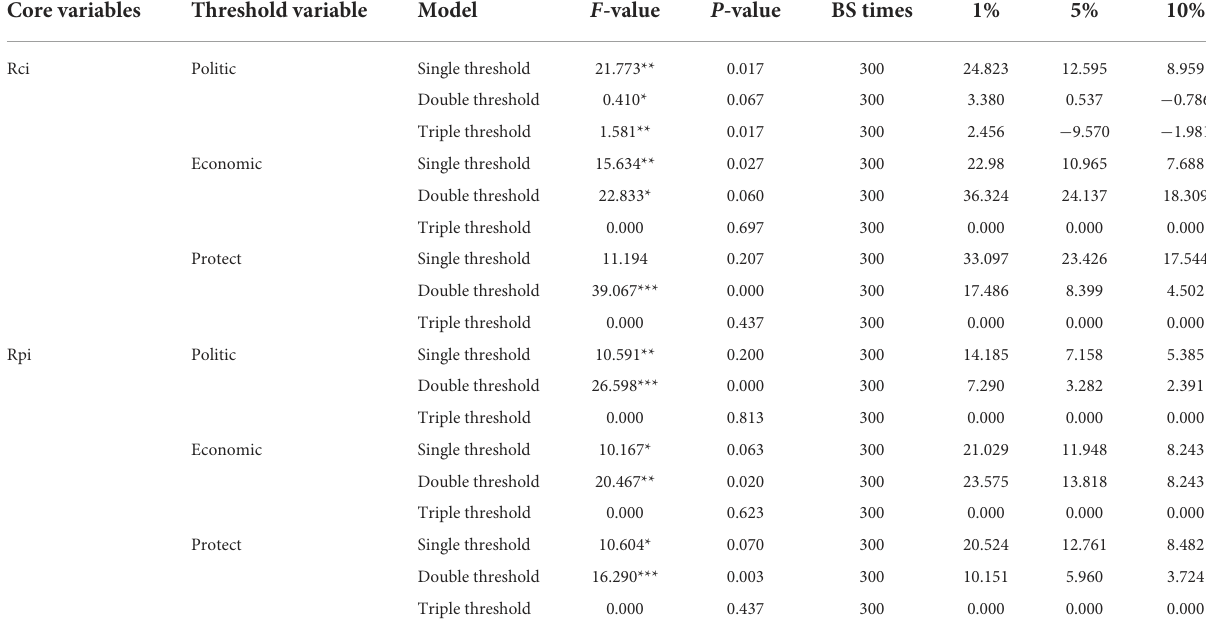
TABLE 3 Threshold effect self-sampling